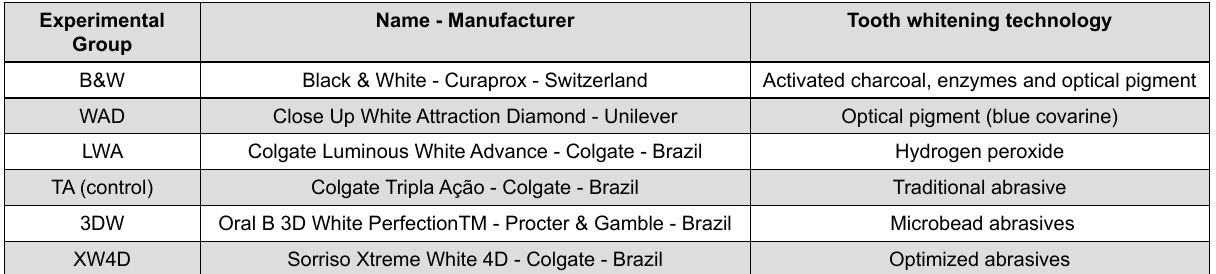
Figure 1- Experimental group, name, manufacturer and the type of tooth whitening technology used in each toothpaste analyzed in this